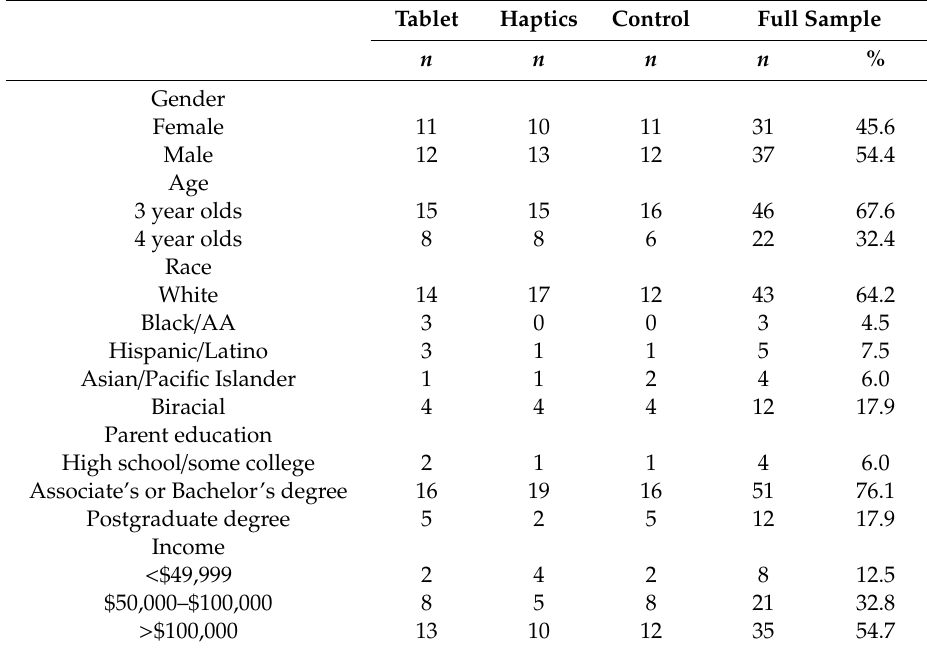
Table 1. Demographic Characteristics of